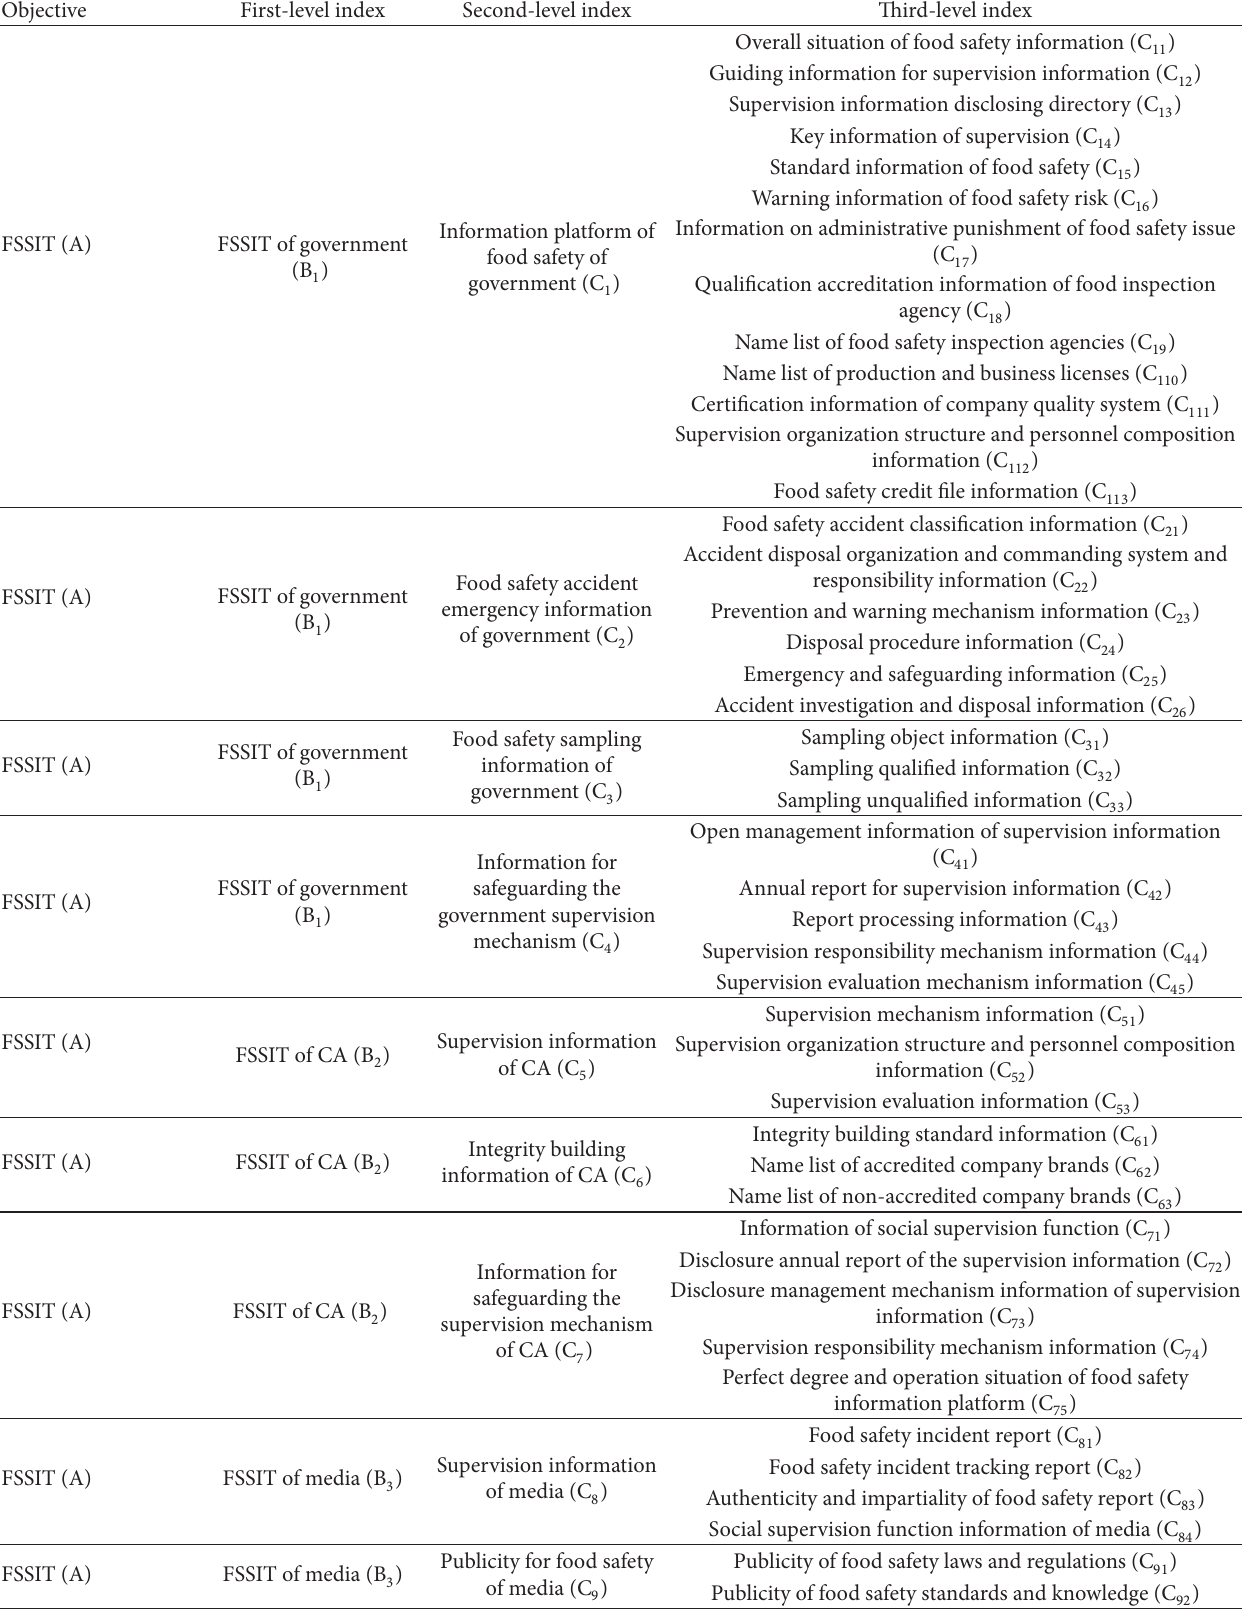
Table 1: Index system of